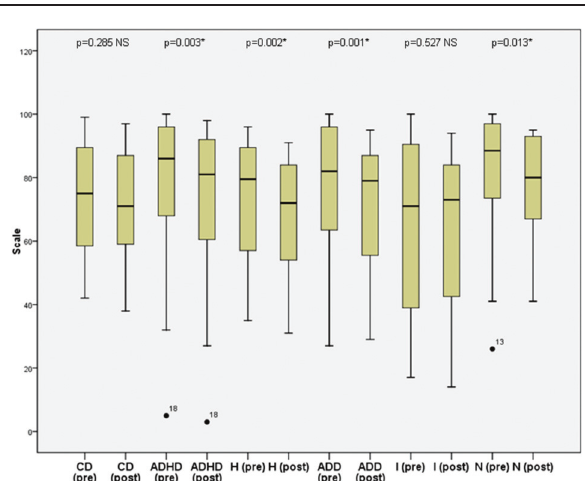
Box and whisker graph of childhood attention and adjustment survey scores in the studied group before (pre) and after (post) therapy. The thick line in the middle of the box represents the median, the box represents the interquartile range (from 25th to 75th percentiles), and the whiskers represent the minimum and maximum after excluding outliers (black-filled circles) (numbers indicate the serial number of the case in the master table). ADD, attention deficit disorder; ADHD, attention-deficit hyperactivity disorder; CD, conduct problems; H, hyperactivity; I, impulsivity; N,